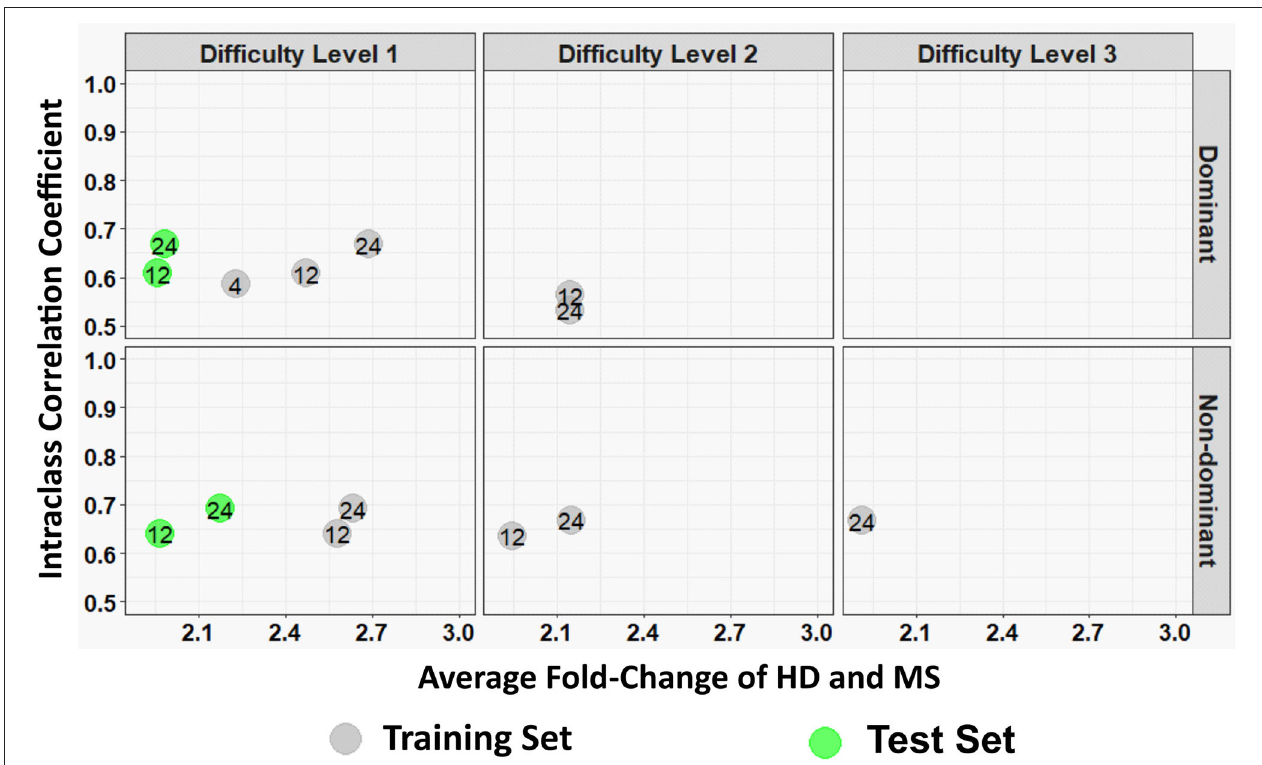
FIGURE 2 | Average fold change (FC) of HD and MS of the spiral-derived features with respect to their Intraclass Correlation Coefficient (ICC) where ICC was calculated from the granular data of HD. The numbers indicate the feature’s labels as illustrated by the label in Table 2 . Gray colors are features from the training set while green colors are from the test set. Here we only include FC > 2 and ICC > 0.5. A diagram of all features that are statistically significant between HD and MS in the training and test set for HD ICC is provided as Supplementary Figures S5, S6, respectively in the Supplementary Material (HD and MS indicate healthy donors and multiple sclerosis patients,